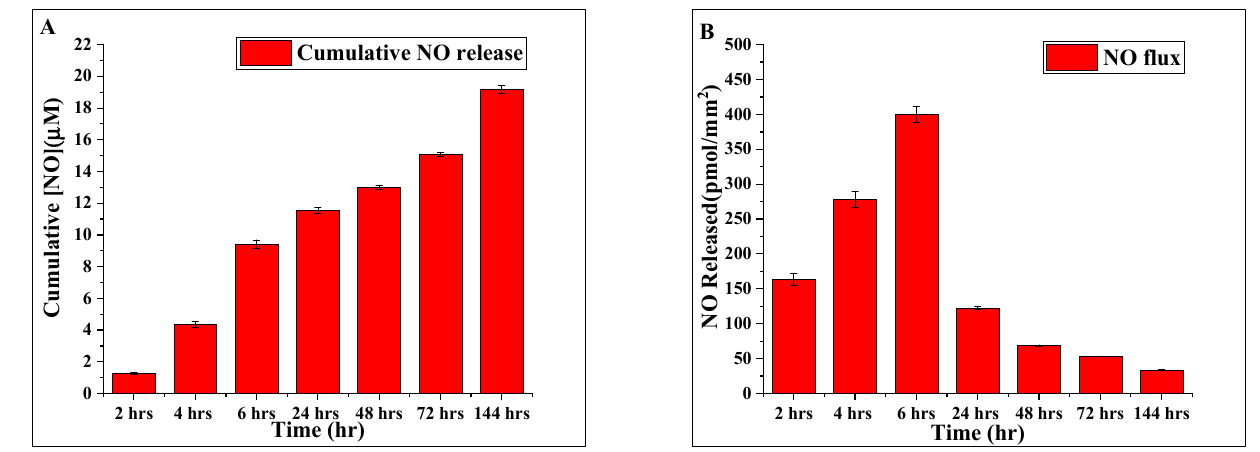
Figure 9. ( A ) Average cumulative NO concentration released from SAP/iNOSox hydrogel over time periods of experiments extending from 2 h to 144 h. ( B ) Average surface NO flux of SAP/iNOSoxy calculated in the form of amounts of NO released per time unit and per unit surface area. Data represents mean ± SD (n = 3).